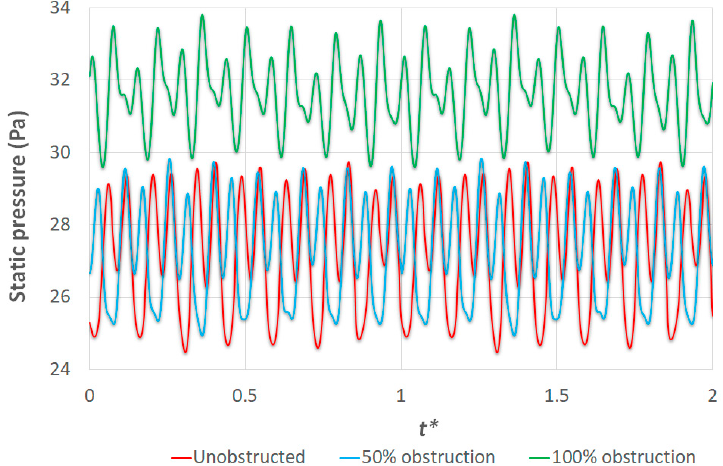
Figure 18. Pressure signal in the inertial reference frame (monitor point E3) for different distributor blockage sizes.